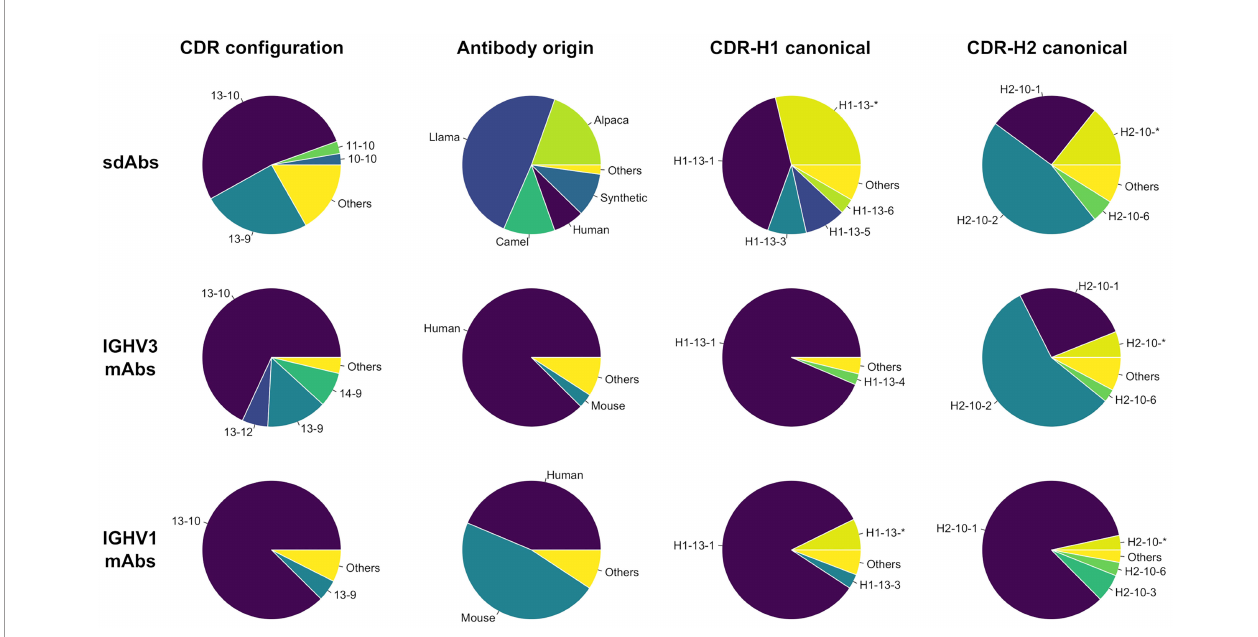
FIGURE 1 | Distributions for the entire set ( fi rst column) and set of antibody structures with CDR con fi guration 13-10 (second, third and fourth columns) are shown for single-domain antibodies and conventional antibodies from the IGHV3 and IGHV1 gene families. The distributions show the groups for (i) CDR con fi gurations with the fi rst and second numbers being the respective lengths for the canonical loops CDR-H1 and CDR-H2; (ii) origins from Human ( Homo sapiens ), Mouse ( Mus musculus ), Llama ( Lama glama ), Camel ( Camelus dromedarius or Camelus bactrianus ), Alpaca ( Vicugna pacos ) and Synthetic; and (iii) canonical structures for CDR- H1 and CDR-H2 as reported by PyIgClassify. The groups encompassing less than 2.5% of the total number of entries were aggregated into Others. Asterisks denote conformations not clustered according to PyIgClassify classi fi